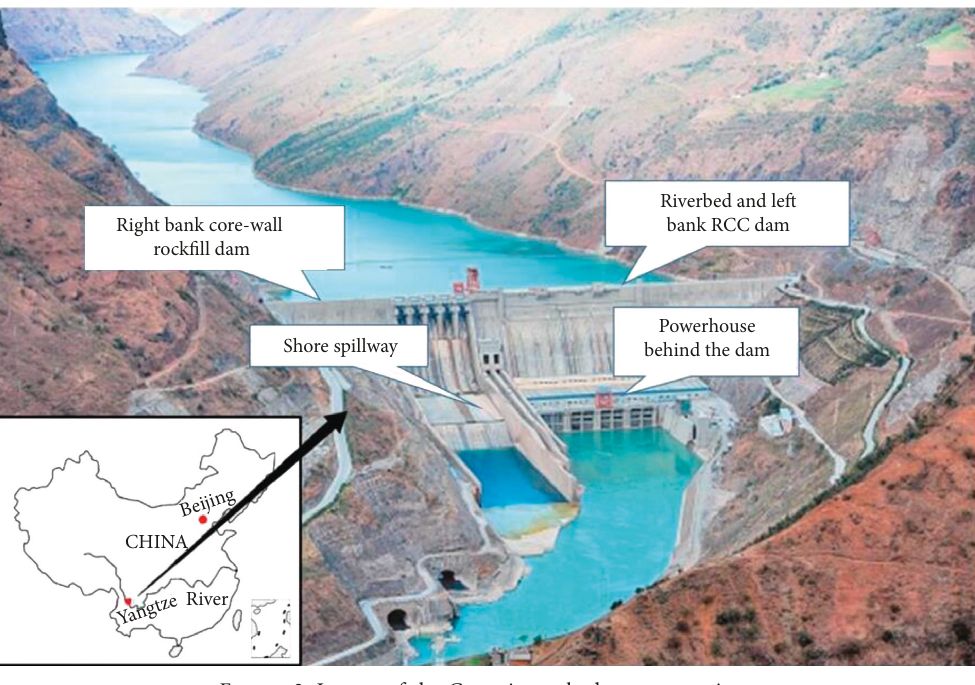
Figure 2: Layout of the Guanyinyan hydropower station.